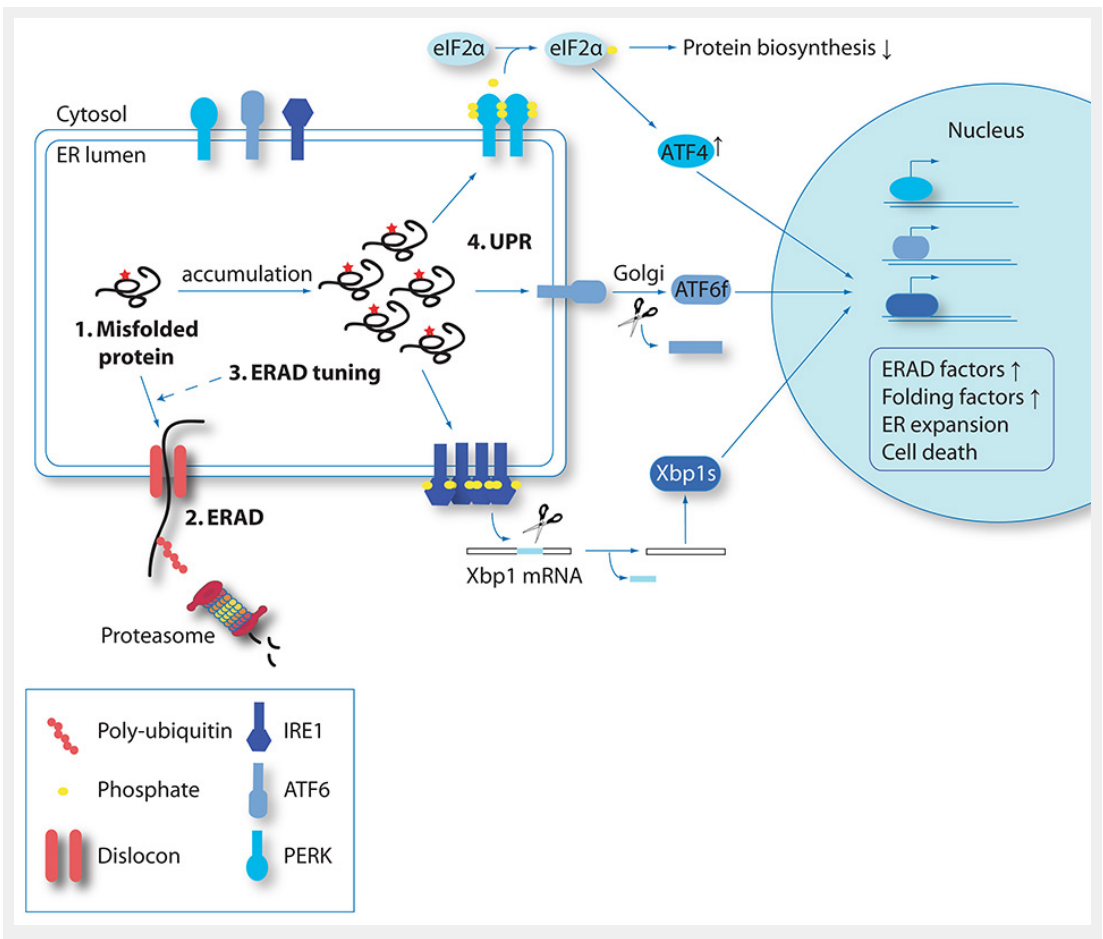
Figure 3 Responses to misfolded proteins in the ER. Misfolded protein species can arise due to the error-proneness of the folding process or due to mutations (red asterisk in step1). They are selected for ERAD (step 2). At steady state, post-translational mechanisms, collectively termed ERAD tuning, are in place to keep ERAD activity under control (step 3). Accumulation of misfolded polypeptides in the ER lumen may trigger the UPR (step 4). IRE1 forms active clusters that remove a short intron from the XBP1 mRNA thus resulting in expression of the active transcription factor XBP1s. ATF6 is transported to the Golgi, where it is cleaved to release the active transcription factor ATF6f. XBP1s and ATF6f are eventually dislocated into the nucleus, where they activate expression of ER stress-induced genes. PERK forms clusters that phosphorylate the elF2α elongation factor thereby attenuating cargo protein synthesis. On the contrary, the translation of the transcription factor ATF4 is specifically enhanced under these conditions and induces the expression of UPR